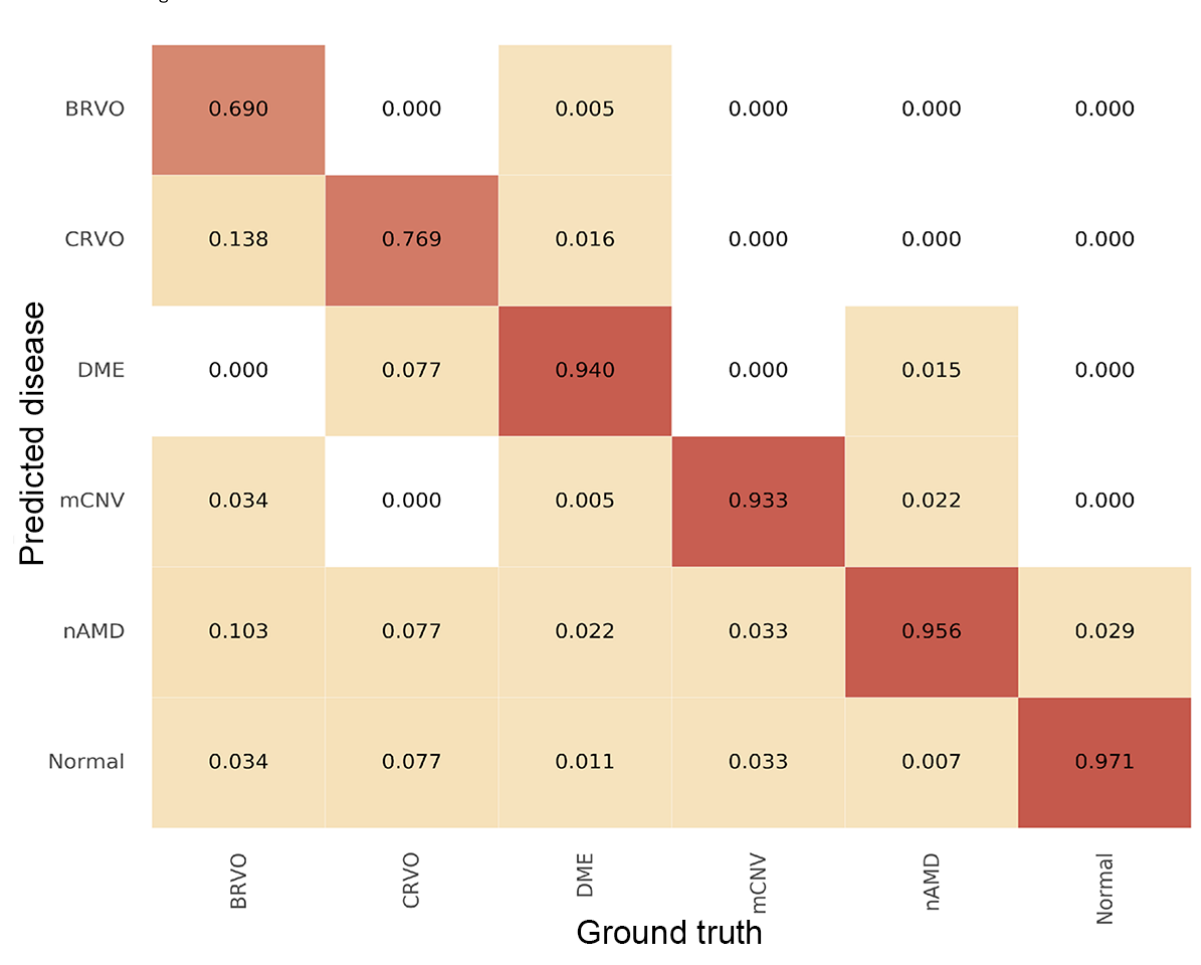
Figure 4. Confusion matrix demonstrating the performance of the prediction model in different retinal vascular diseases. BRVO: branch retinal